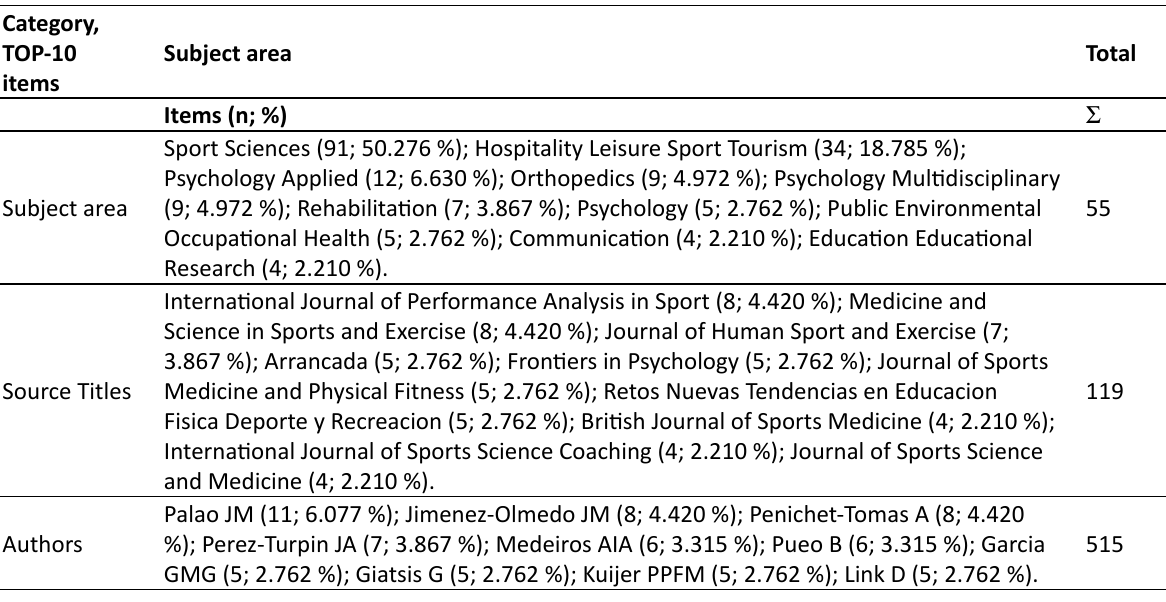
Table 1. Results analysis table for Web of Science categories field / Source Titles / Authors (number of articles - n